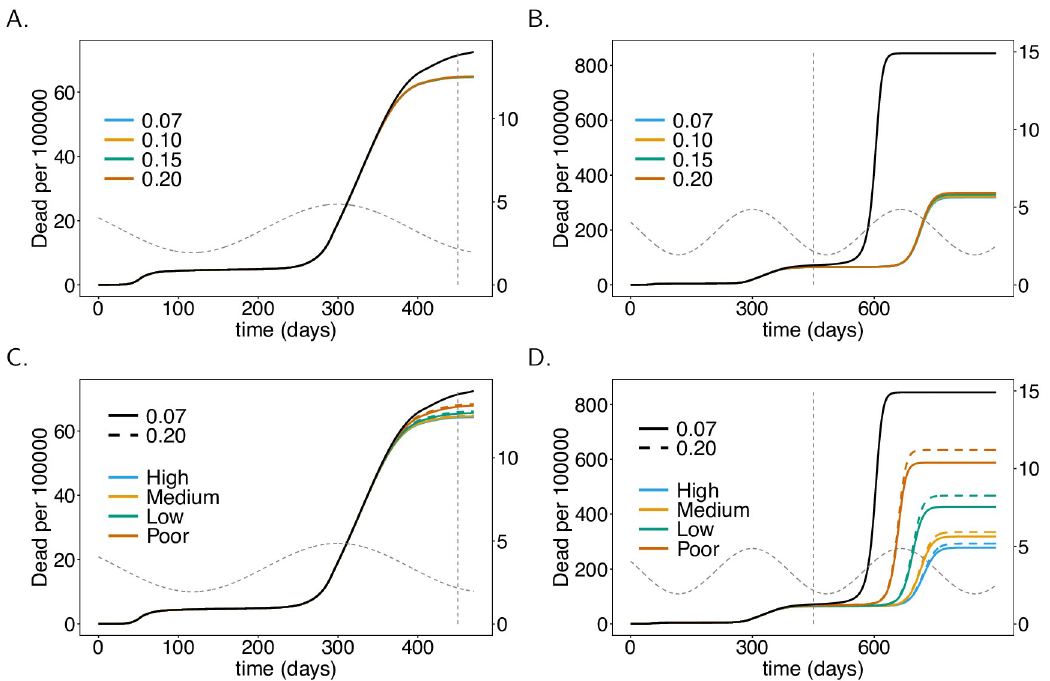
Fig 9. ADE-induced increased mortality. As Fig 8, but for different levels of ADE-induced mortality instead of vaccination coverage. A vaccination coverage of 60% was assumed. Panels show only mortality. For the corresponding incidence see Fig